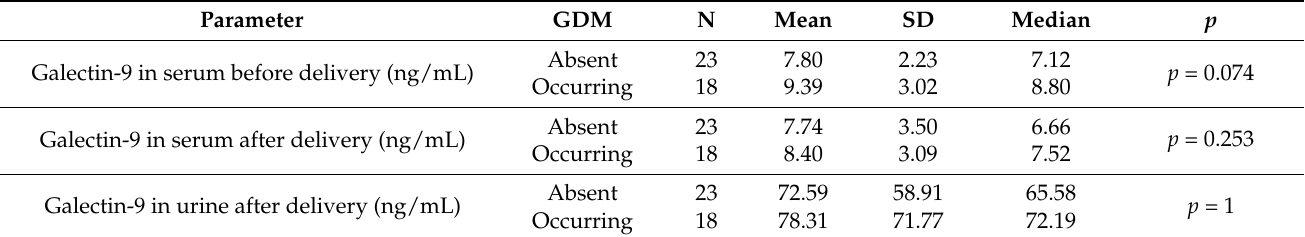
Table 3. Comparison of galectin-9 concentration.